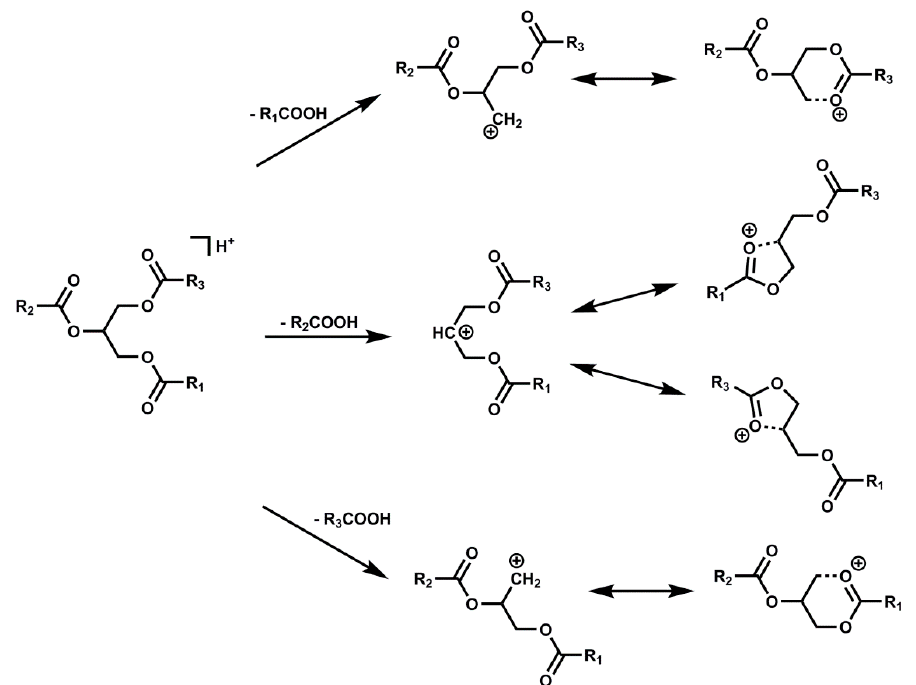
Figure 4. Schematic representation of fatty acids elimination from sn-1, sn-2 and sn-3 positions by ESI( + ) MS.